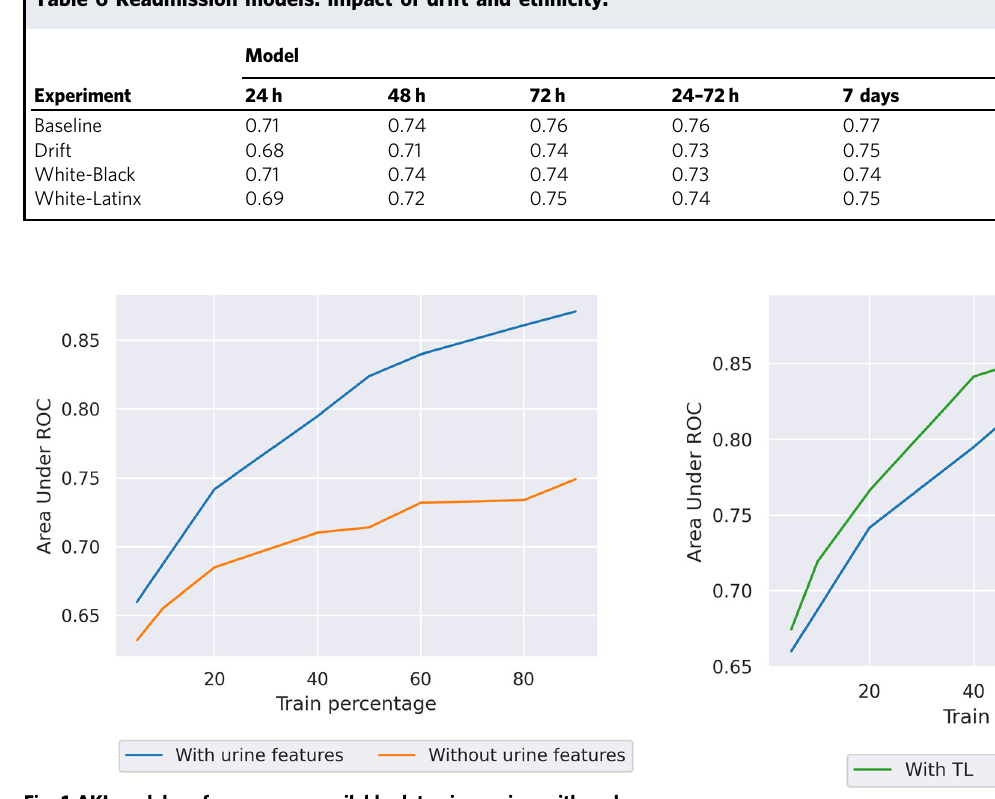
Fig. 2 AKI model performance as available data size varies, with and without TL. Area under receiver operator curve (AUROC) of acute kidney injury (AKI) against dataset size, without transfer learning (TL), i.e., the baseline model (blue line), and with simple TL (green line). The transferred model needs less data to achieve the same performance as the model retrained from scratch, showing that there is an advantage in using transfer learning in cases where little data is present. Source data is in Supplementary Data 2.